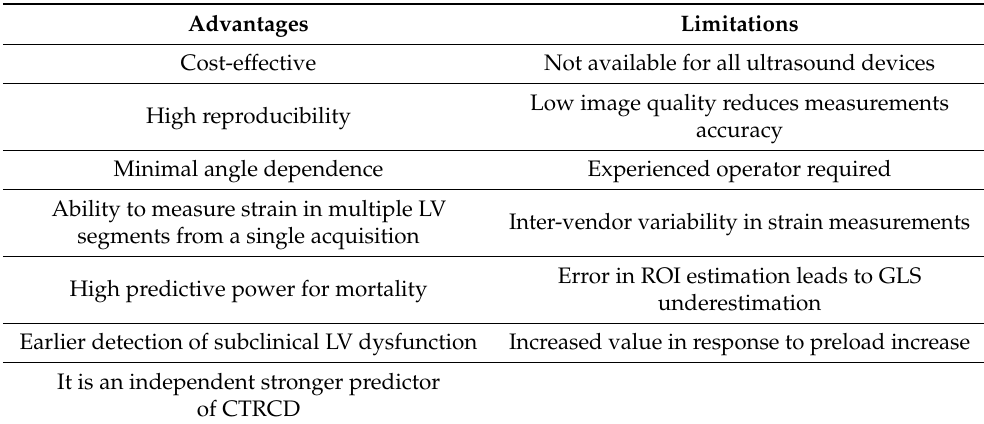
Ability to measure strain in multiple LV segments from a single acquisition High predictive power for mortality Earlier detection of subclinical LV dysfunction It is an independent stronger